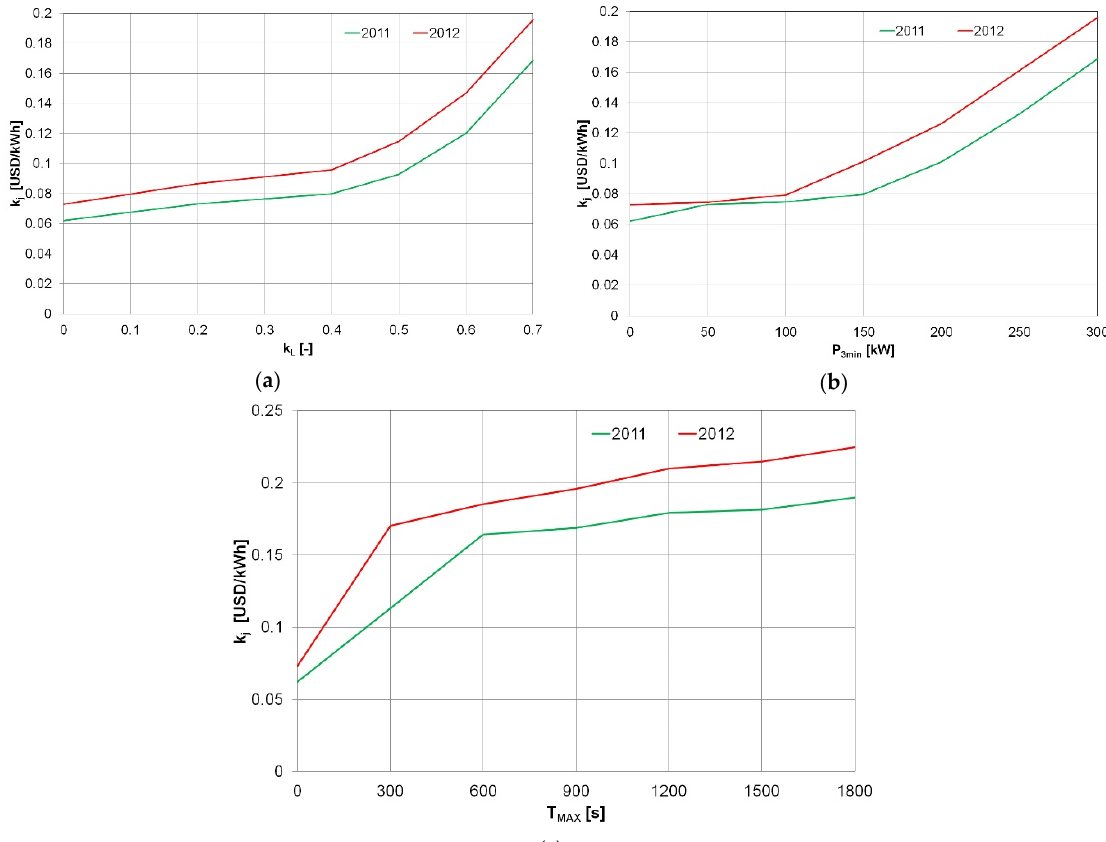
Figure 10. Comparison of the value of the discounted unit cost of energy generation in the optimised WPP-FESS system in 2011 and 2012 as a function of: ( a ) allowable interruption index k L (P 3MIN = 300 kW, T MAX = 900 s); ( b ) P 3MIN power (T MAX = 900 s, k L = 0.7); ( c ) T MAX time (P 3MIN = 300 kW, k L = 0.7).